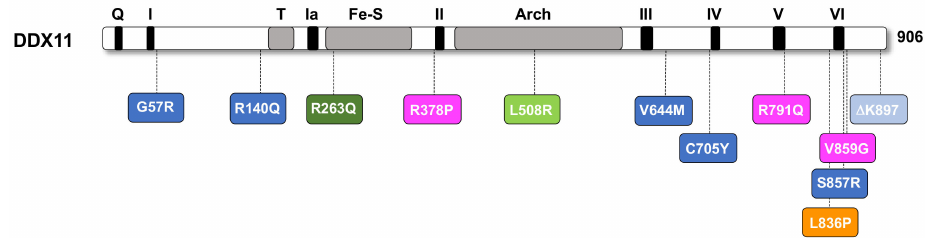
Figure 3. Amino acid substitutions of DDX11 found in Warsaw breakage syndrome (WABS) patients. A schematic representation of the human DDX11 polypeptide chain is reported. Color code is as in Figure 1 for black and grey elements. DDX11 pathogenic mutations described in the same article are highlighted with the same color: light blue [8]; indigo [17]; dark green [76]; light green [77]; pink [78]; orange